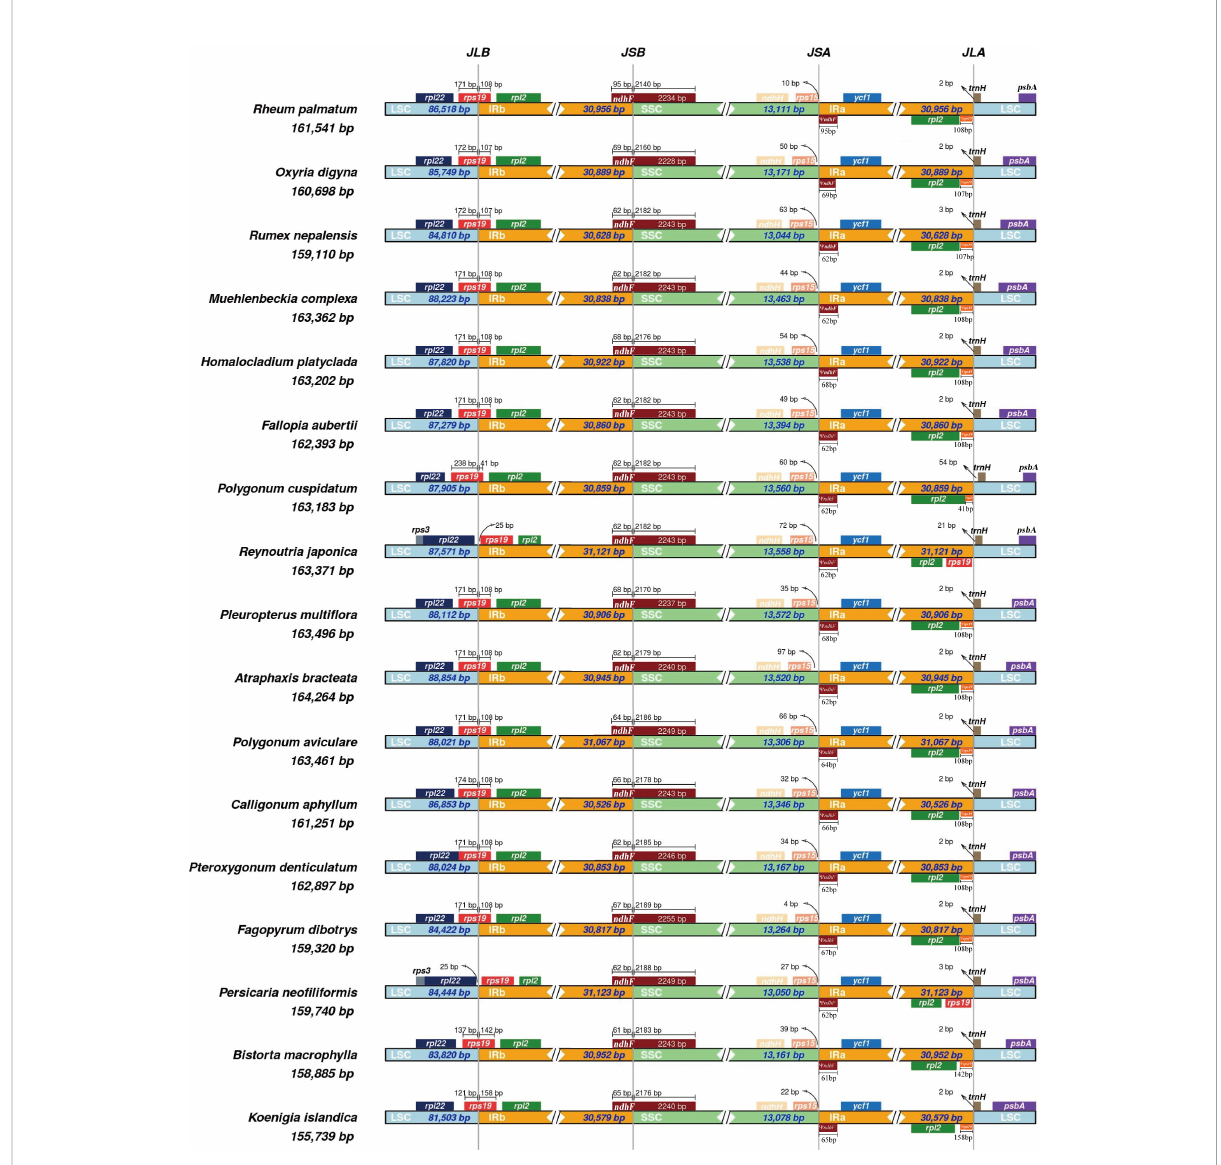
FIGURE 1 The IR/SSC borders in the plastomes of 17 genera of Polygonoideae. JLB, JSB, JSA and JLA denote the junction sites of LSC/IRb, SSC/IRb, SSC/ IRa and LSC/IRa